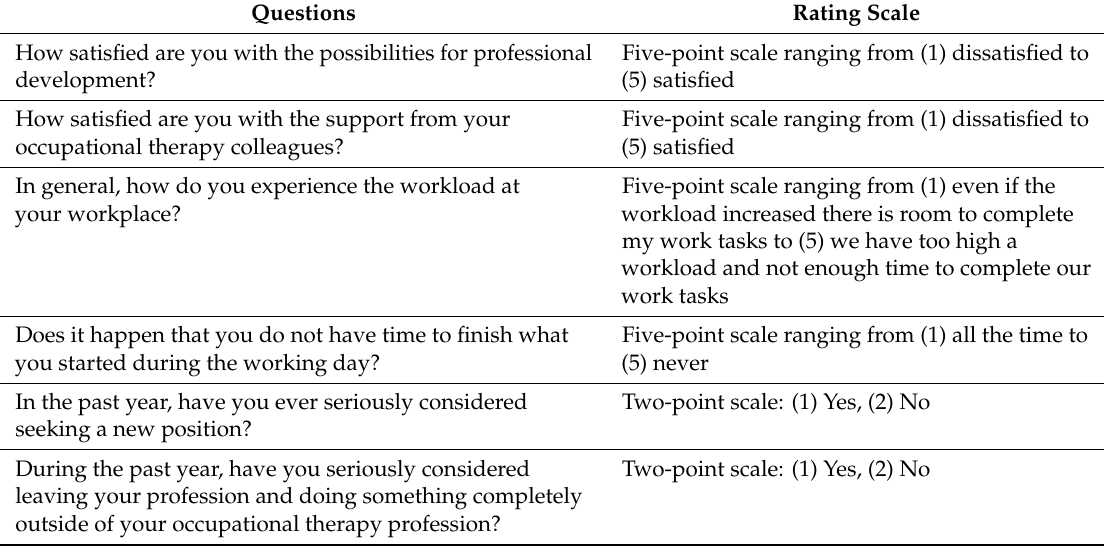
Table 1. General questions related to the social and organizational work environment, and job turnover included in the web